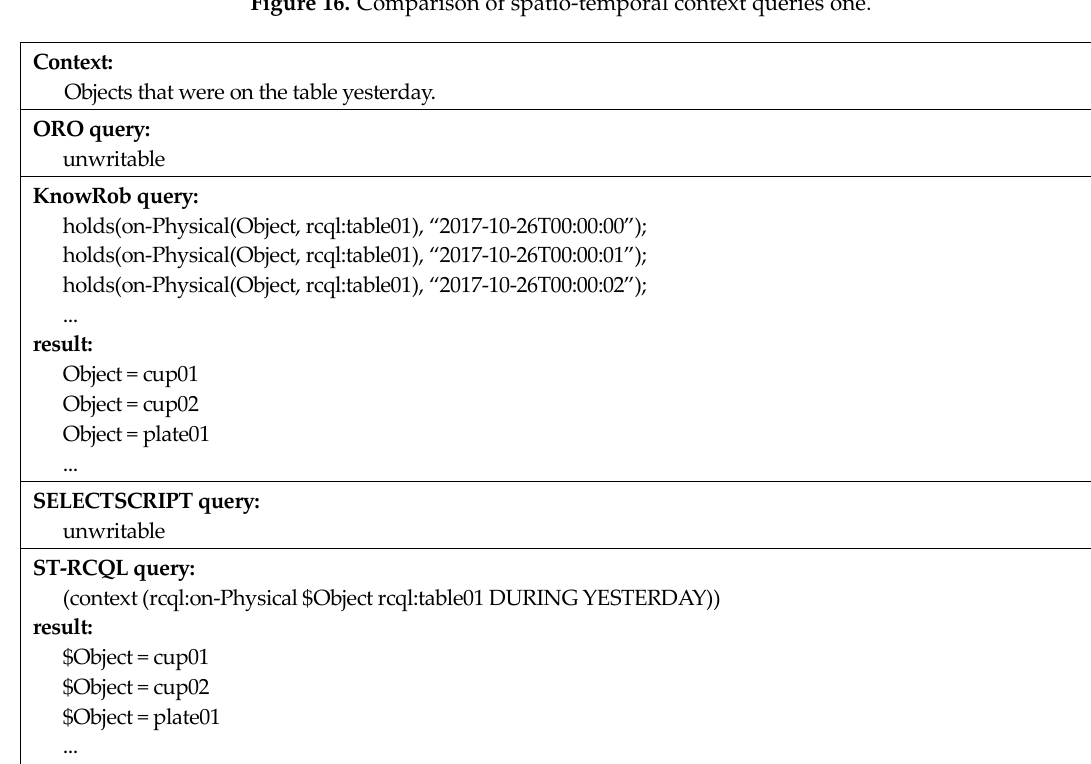
Figure 16. Comparison of spatio-temporal context queries one.